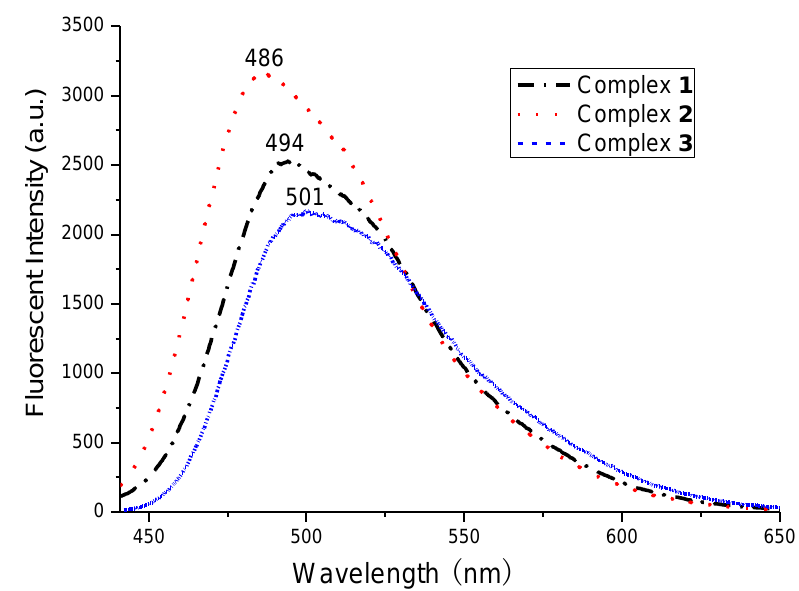
Figure 13. Emission spectra of the Mn III complexes 1 , 2 and 3 ( λ ex = 320 m) in DMF solution (5.0 × 10 −5 mol/L).